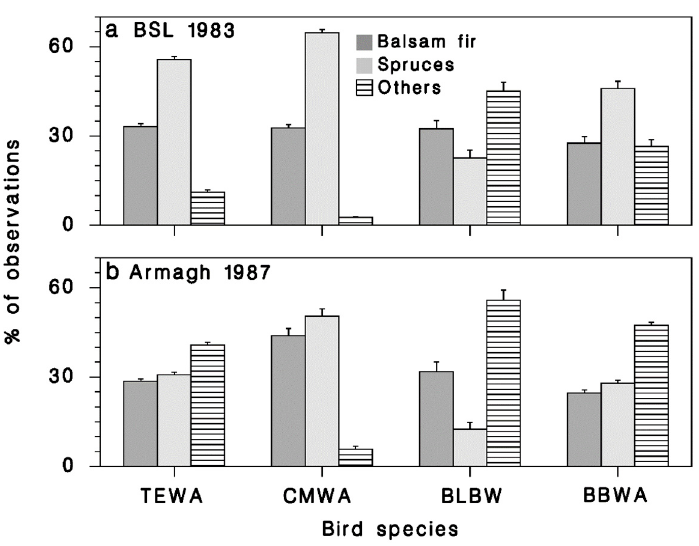
Figure 8. Relative frequency of observations recorded on various tree species, at ( a ) BSL in 1983 and ( b ) Armagh in 1987, gouped by bird species. Vertical lines: standard error